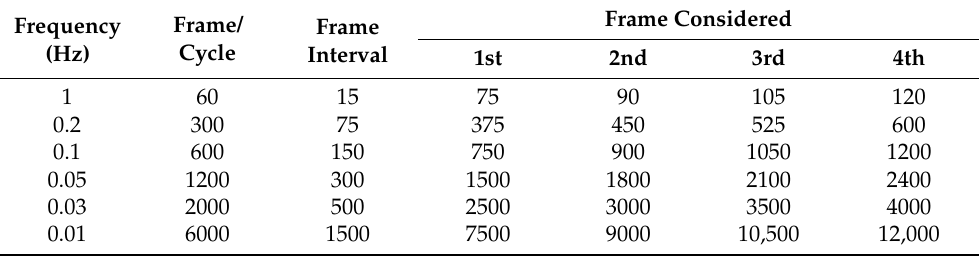
Table 2. Details of experimental lock-in frequency modulated thermal wave imaging data.